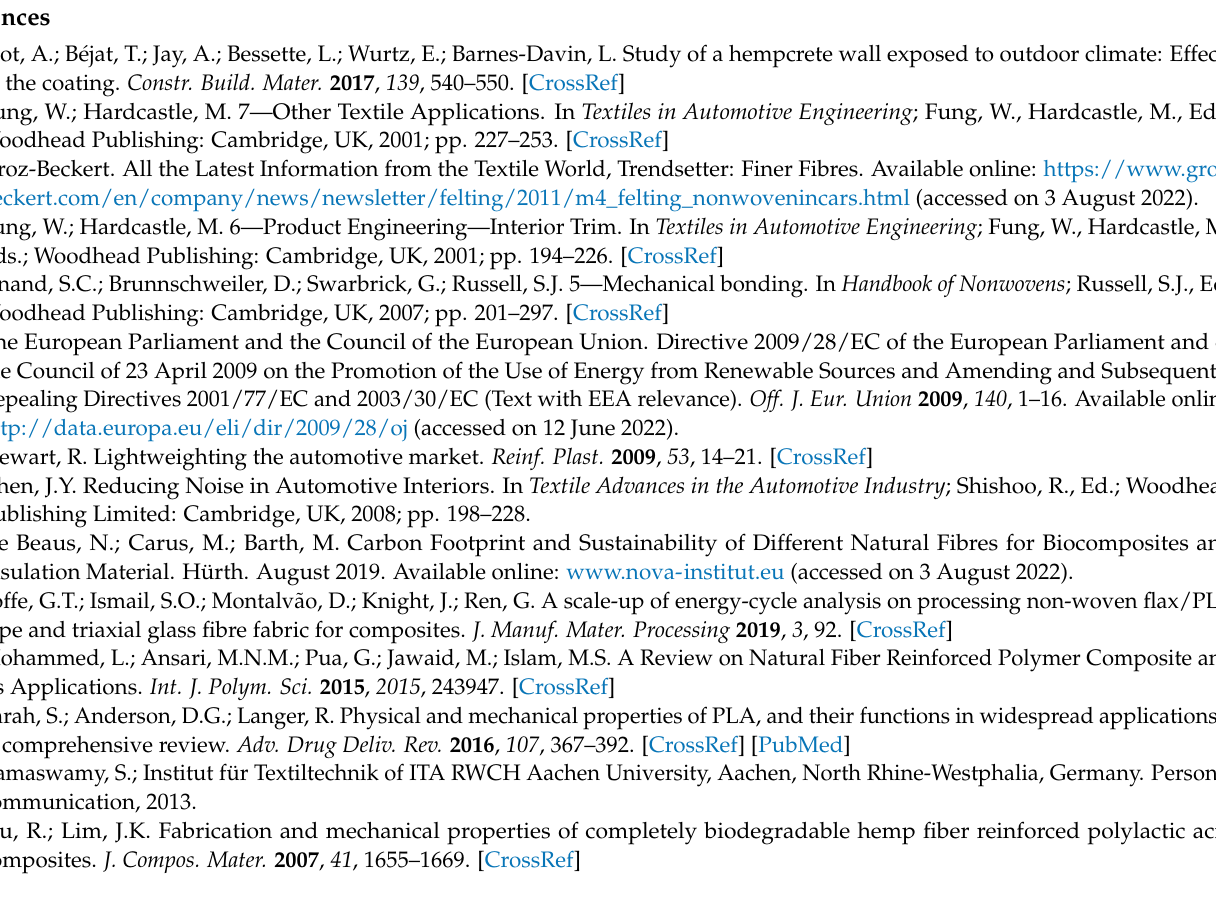
Table S4: Economic allocation of flax straw